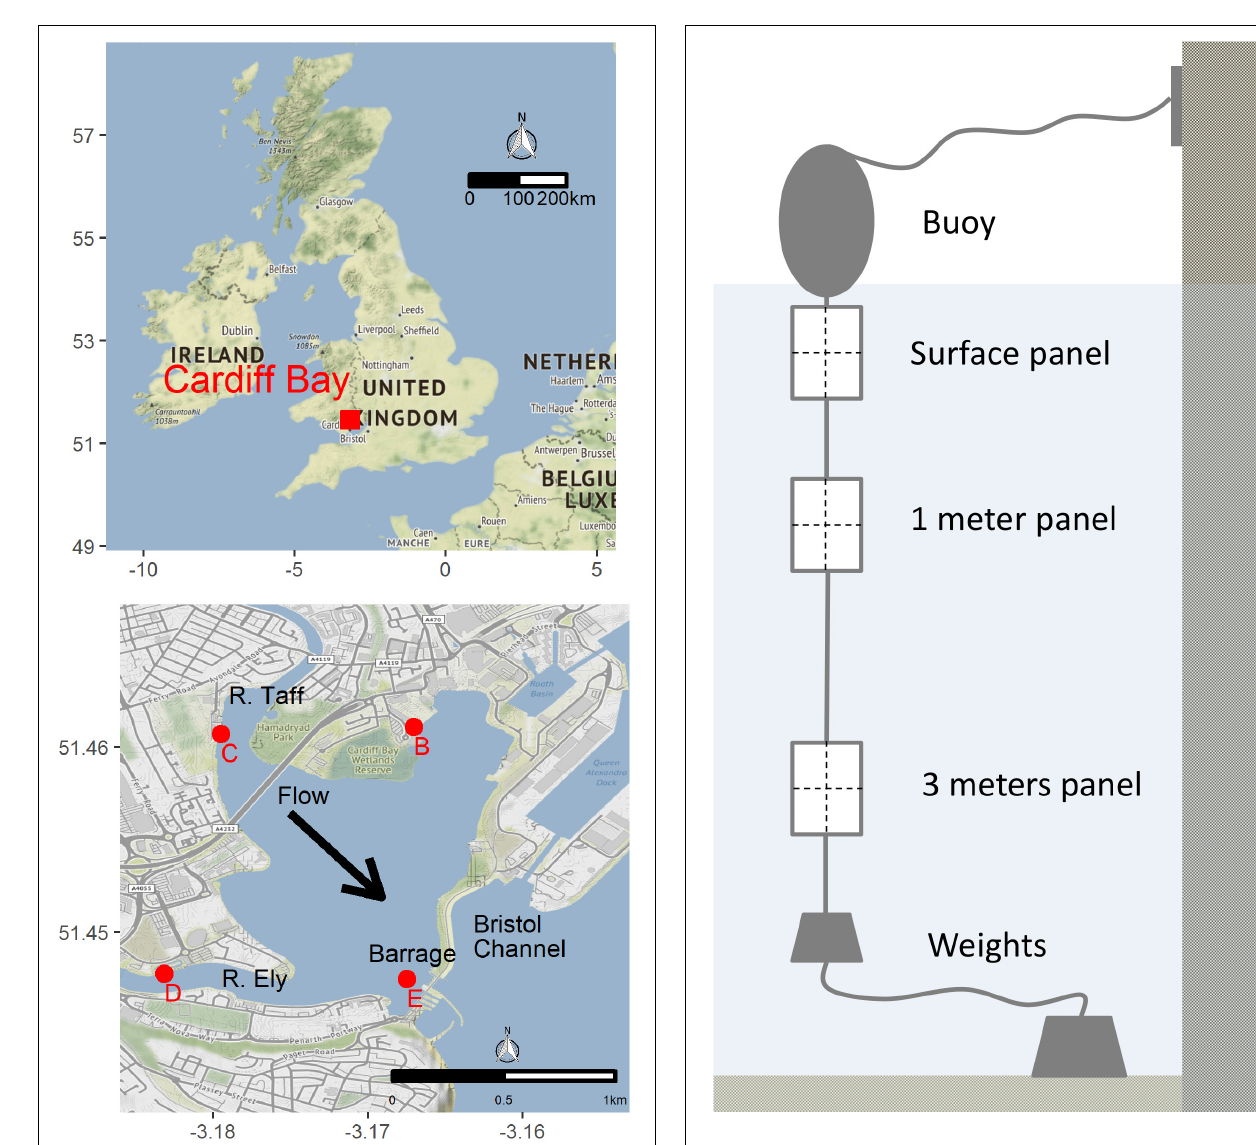
FIGURE 2 | Experimental buoys used to assess the influence of water depth and density on zebra mussel population dynamics. Each month 25% of the area of each side-panel (156 cm 2 ) was scrapped clean and all the attached zebra mussels were counted and measured.